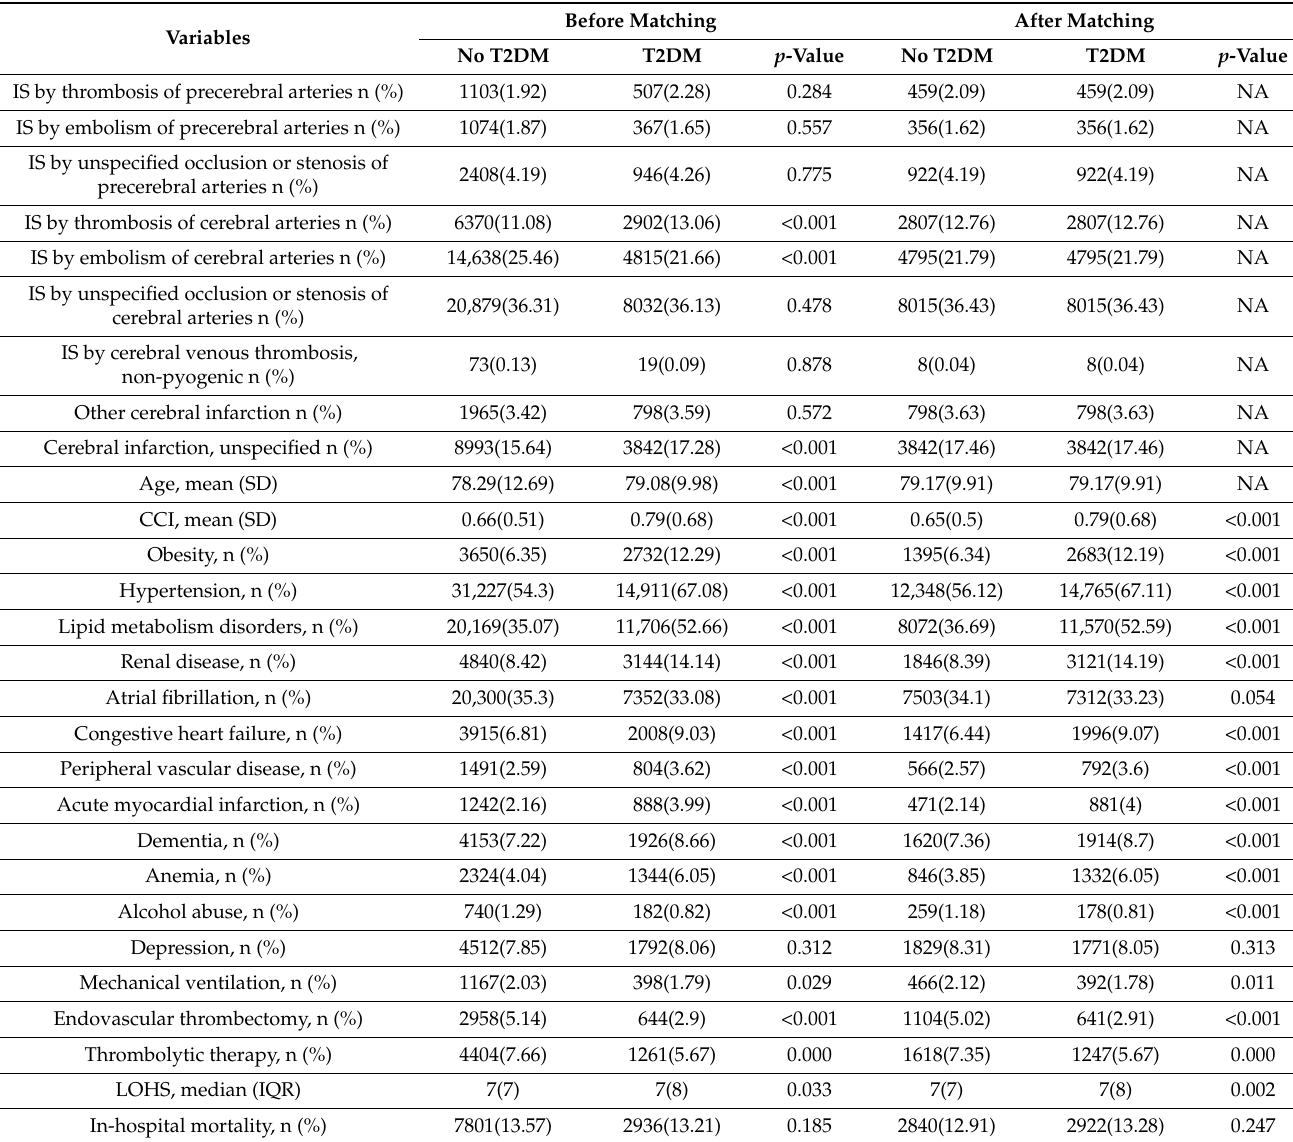
Table 3. Clinical characteristics, use of therapeutic procedures, and hospital outcomes before and after matching by age and ischemic stroke type (ICD 10) for women patients with ischemic stroke